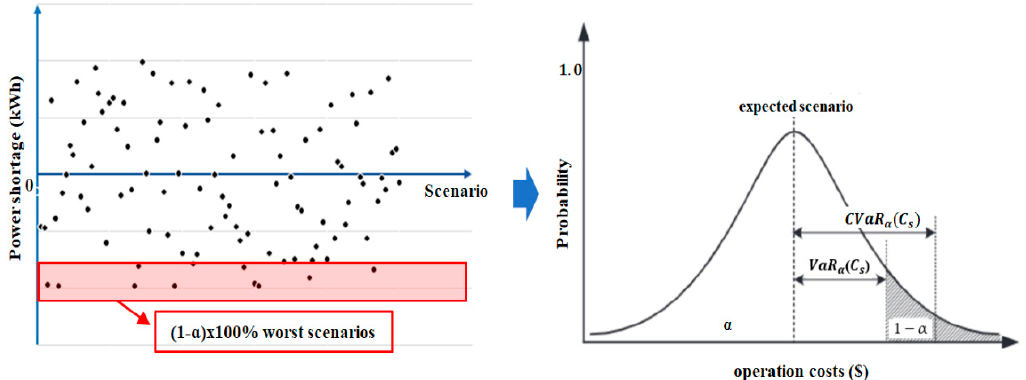
Figure 2. Determination of α confidence level conditional value at risk ( α -CVaR) as a function of power shortages.